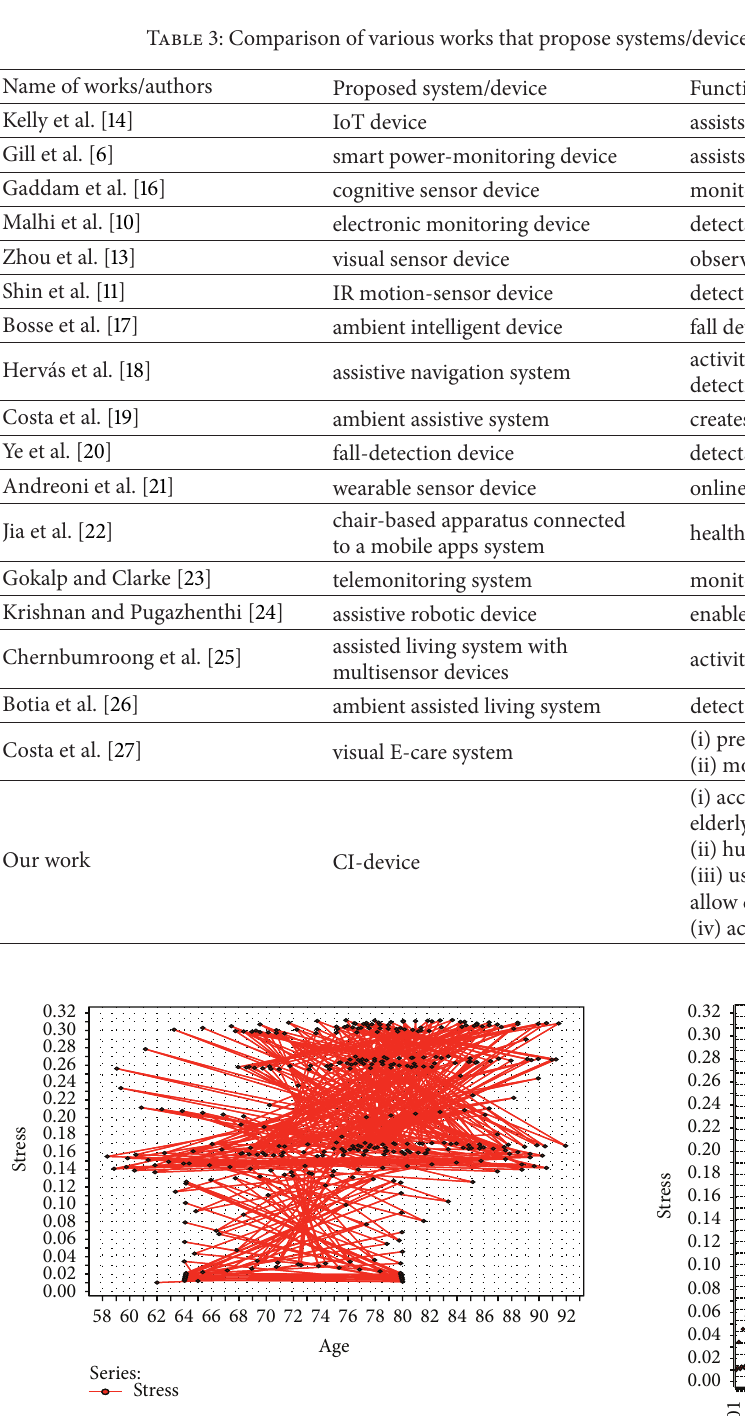
Figure 4: Stress-level analysis in the elderly based on age clusters.